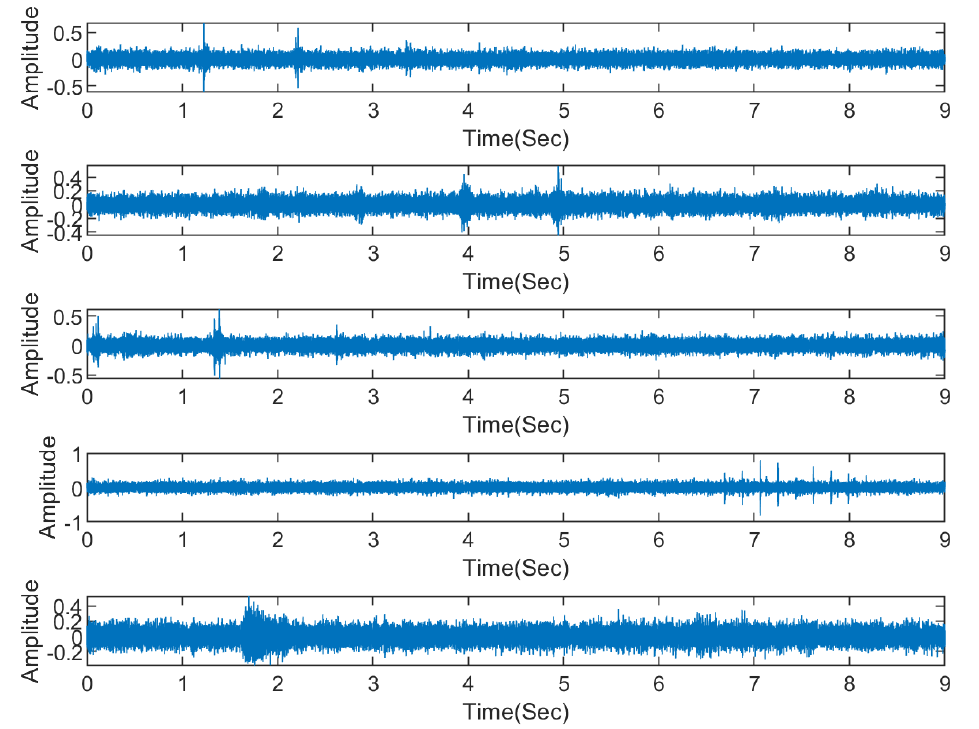
Figure 5. Selected examples of noncyclic impulsive signals corresponding to signal